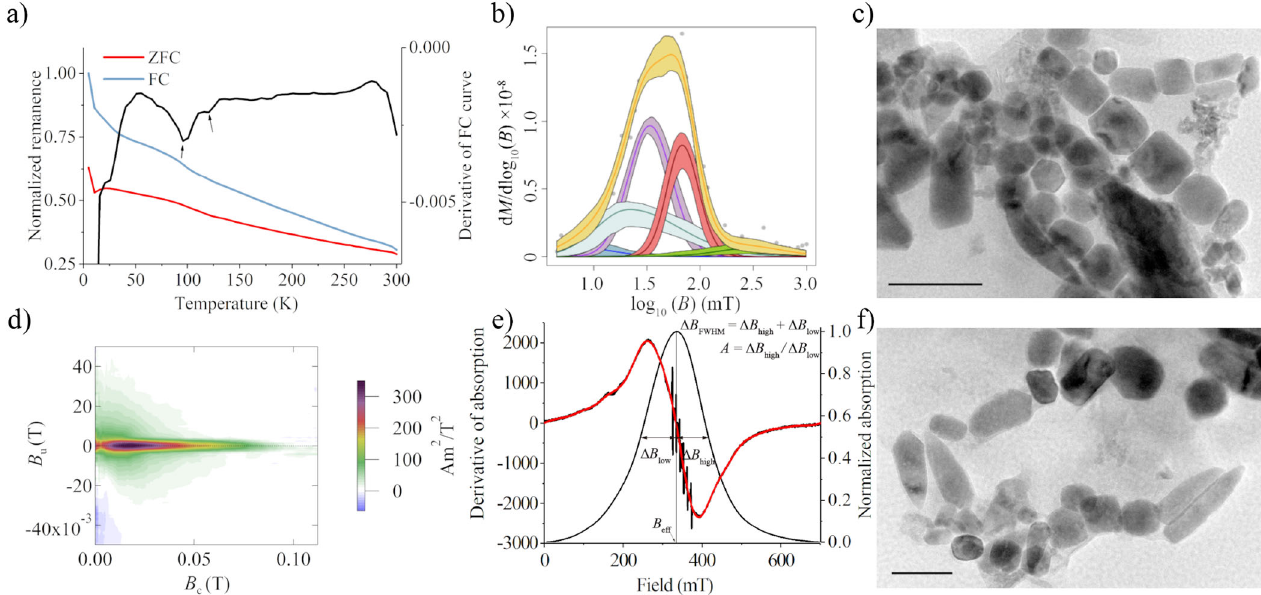
Fig. 3 Methods for identifying magnetofossils in samples from core MD01-2444 at 26.74 m depth. a Low-temperature magnetic measurements (blue and red curves: normalized zero- fi eld cooled (ZFC) and fi eld cooled (FC) curves, respectively; black curve: normalized fi rst derivative of the FC curve; peaks with arrows (~100 K and ~115 K) are indicative of biogenic and detrital magnetite, respectively). b Coercivity distribution from IRM acquisition curve unmixing (gray dots: IRM acquisition data; orange curve: spline fi t based on measured data; purple and red curves: biogenic soft and biogenic hard components, respectively; shaded areas for each curve are 95% con fi dence intervals). c , f TEM images of magnetic extracts from the same sample. Scale bars: c = 200 nm, f = 100 nm. The main magnetofossil morphotypes are prisms, octahedra and bullets. d FORC diagram with a central ridge signature that is indicative of non-interacting single-domain magnetic particles. e Ferromagnetic resonance (FMR) and FMR absorption spectra (black curve: measured FMR spectrum; red curve: fi tted FMR spectrum; black humped curve: normalized FMR absorption spectrum). De fi nition of commonly used magnetofossil-indicative parameters are shown in ( e ) 123